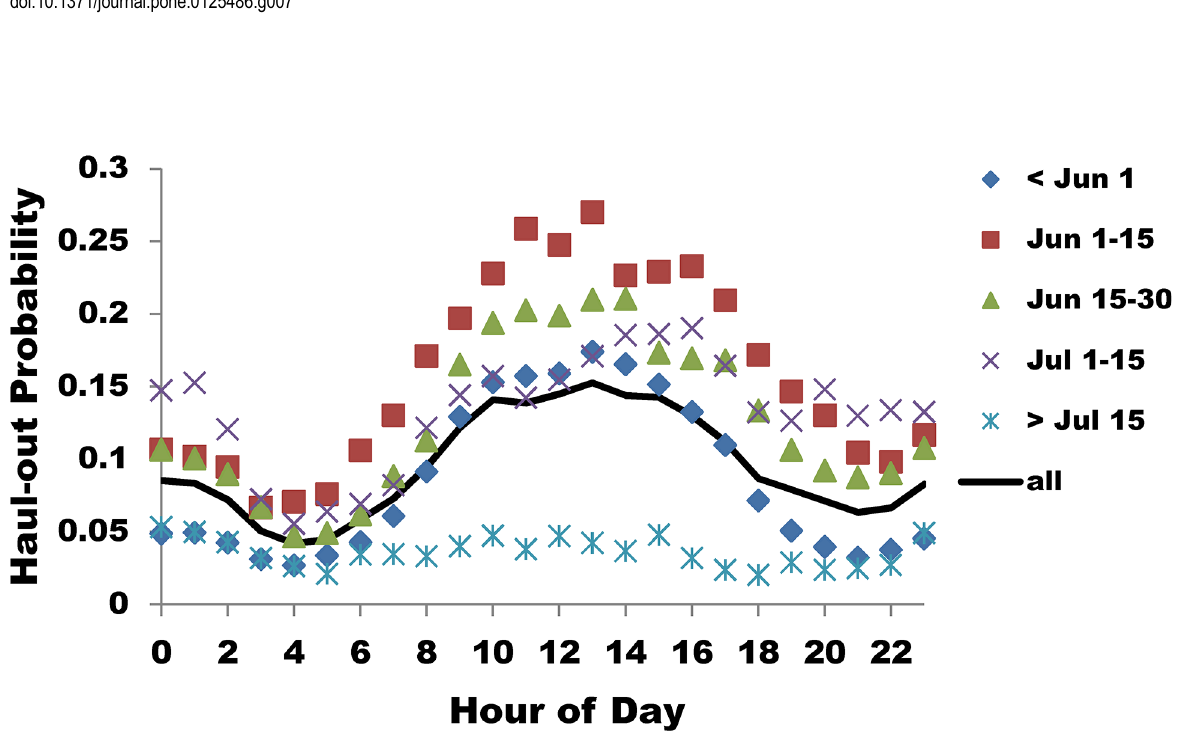
Fig 8. The probability that radio-tagged harbor seals were hauled out by hour of the day and season. Haul-out probability for radio-tagged harbor seals in Endicott and Tracy Arms combined, relative to hour of the day during each of five ~2 week